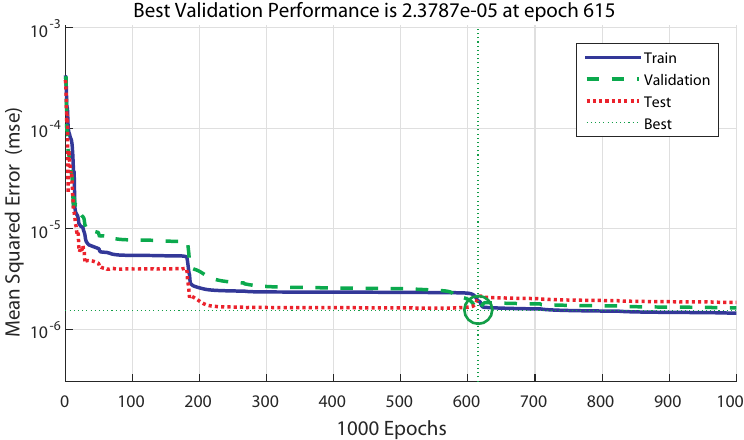
Figure 17. Training performance for a network of 2 × 4 × 8 × 1